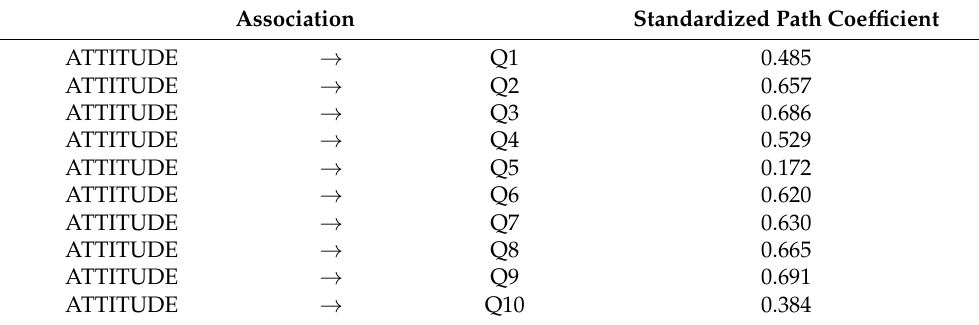
Table 6. Standardized path coefficients of the final selected SEM model for the association between the dependent factor of “Attitudes” and relative items for its construction from the